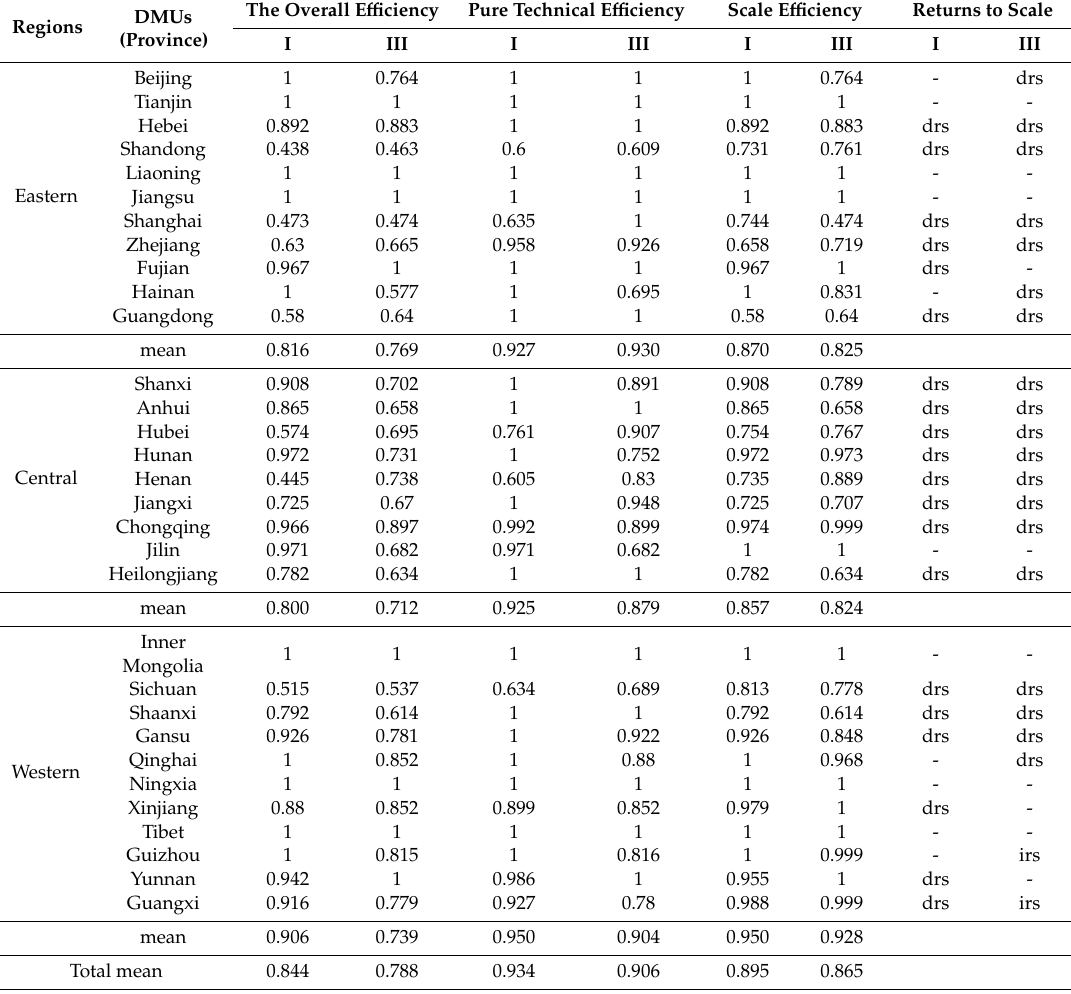
Table 3. The investment results of the first stage and the third